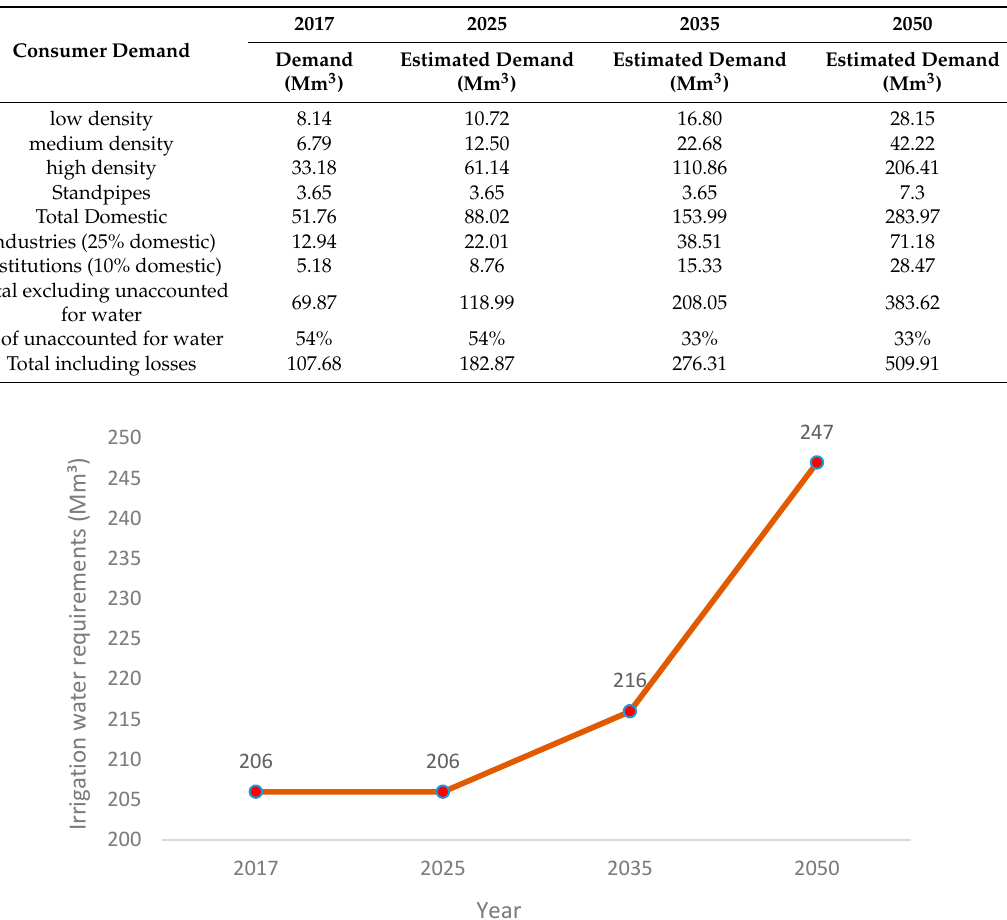
Figure 5. Present and projected water demand for Kano River Irrigation Project (KRIP).